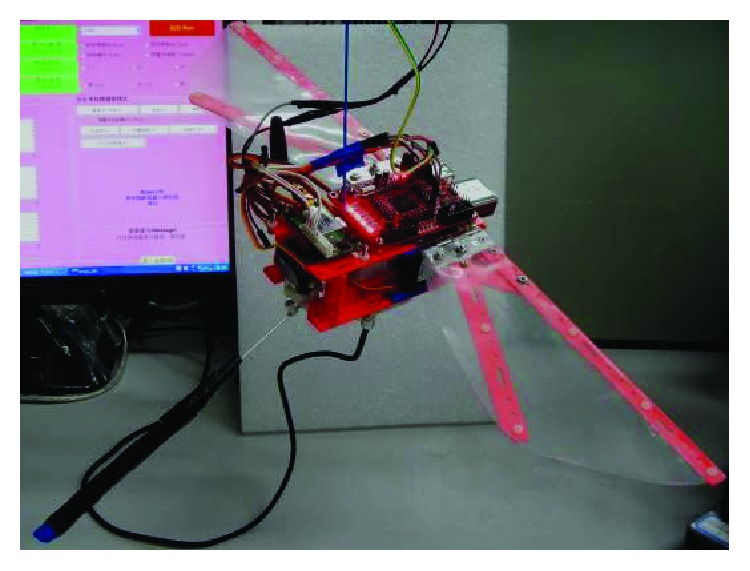
Locust air-posture righting robot [80].